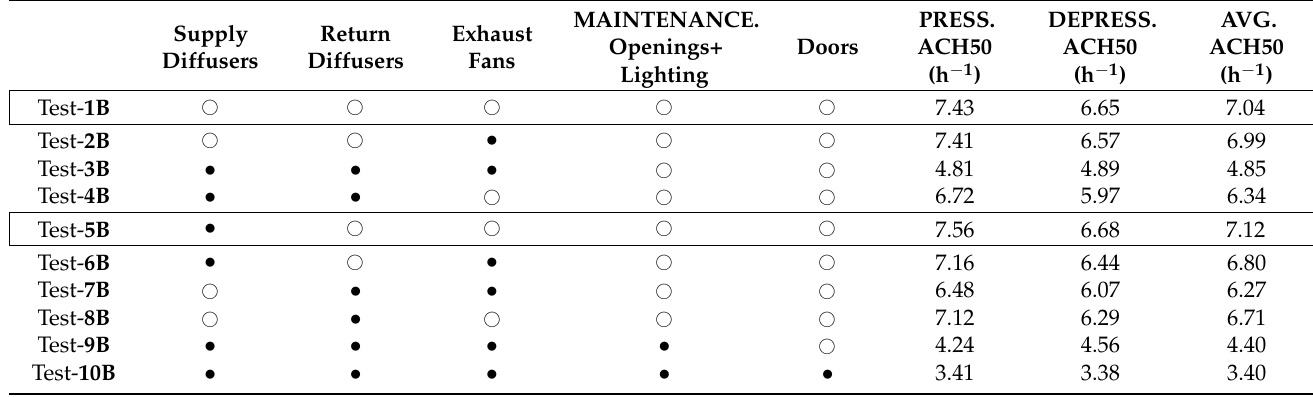
Table 3. Airtightness test results of House A . Table 4. Airtightness test results of House B. Table 4. Airtightness test results of House B.